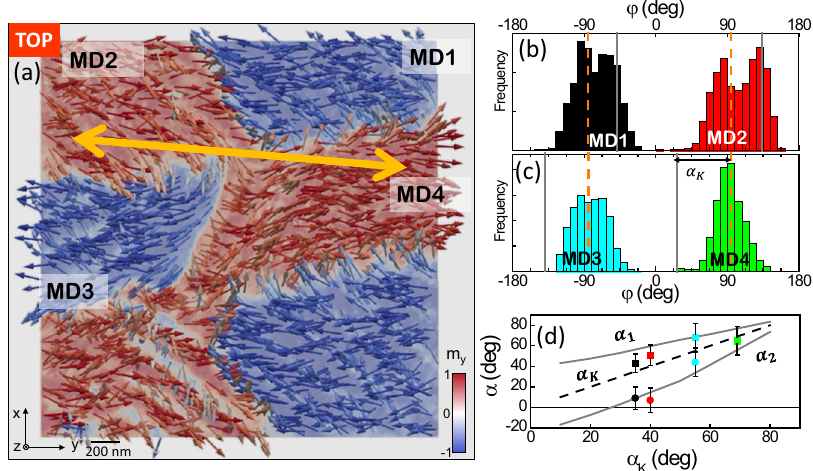
Fig. 6 Statistics of magnetic moment orientation in the quasi domains. a Vectorial tomogram reconstruction of m Gd ð Þ at the ð x ; y ; 14nm Þ plane (Top Gd- Co layer) with m y contrast. Red/blue regions correspond to average in-plane domains with opposite m y contrast. Double arrow indicates the easy anisotropy axis derived from the analytical model. b , c Histograms of in-plane angular orientations ( φ ) respect to the x -axis for the different MDs. Vertical solid lines indicate stripe orientation φ MD stripe in each MD region and vertical dashed lines indicate easy axis orientation φ K : ( d ) Ripple-like domain orientation α α α K . Solid lines are calculated from the analytical model with the same parameters as in Fig. 5. Symbols correspond to 1 (squares) and 2 (circles) vs. experimental α 1 and α 2 obtained from the shortest angular distance between maxima in the histograms and φ MD stripe . The parameter α K in each MD is obtained from the shortest angular distance between φ MD stripe and φ K as indicated in ( c ). Error bars are one standard deviation from the mean, calculated in the angular range around each maximum in the